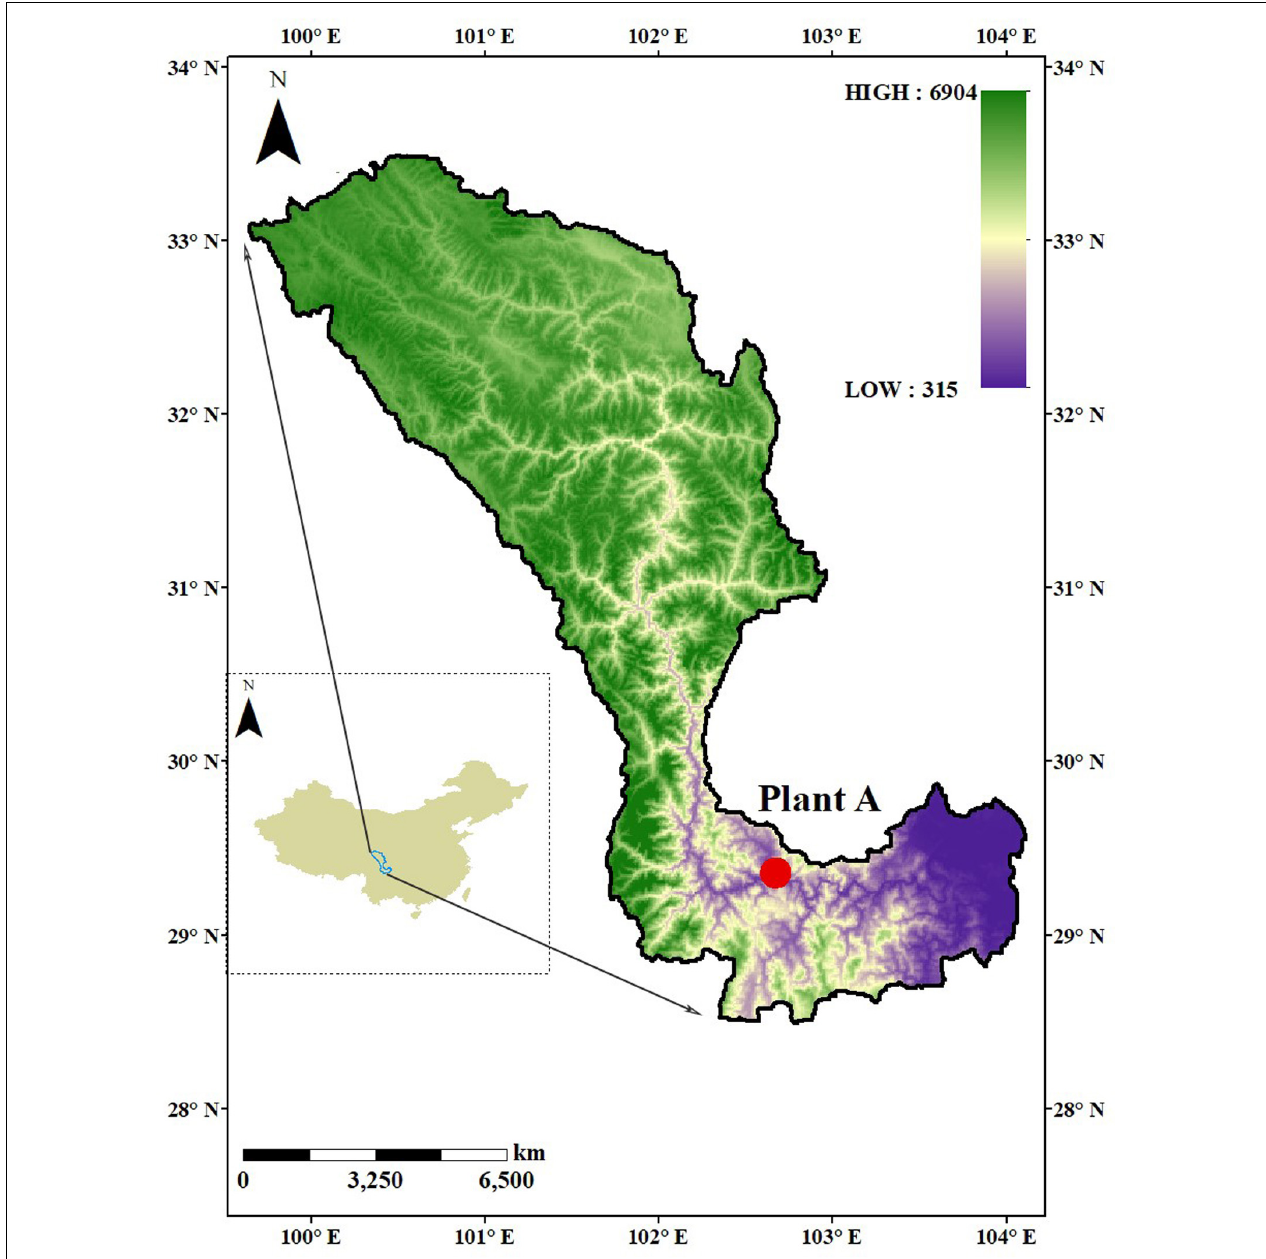
FIGURE 4 | Dadu River